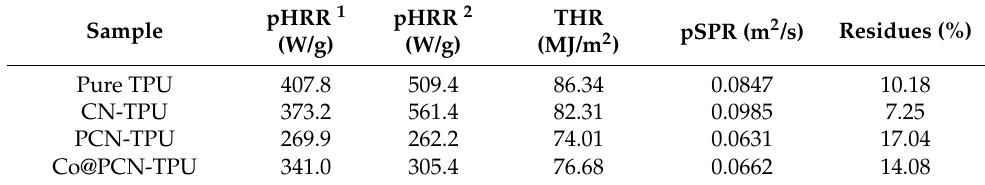
Figure 7. ( a ) Heat release rate and ( b ) total heat release curves of TPU and its nanocomposites obtained from microcalorimetry (MCC). Table 4. Combustion parameters of TPU and its nanocomposites obtained from MCC and CCT. Sample